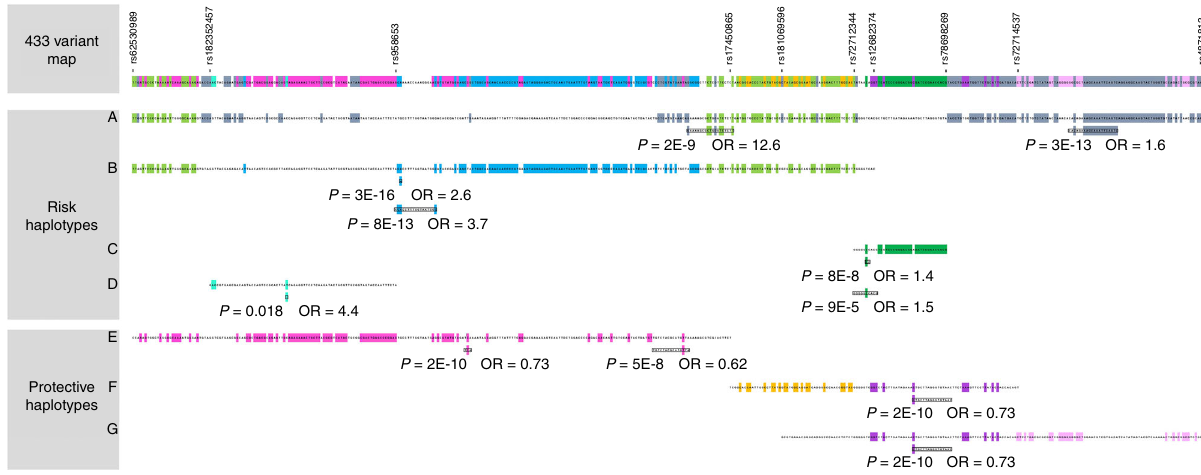
Fig. 3 Seven HPC risk-altering haplotypes carry the minor alleles of the 8q24 prostate cancer risk variants. These haplotypes are comprehensively reconstructed from all associated variants, displayed ordinally rather than on a physical scale. Four haplotypes conveying risk are illustrated above three others conveying protection. Each haplotype is distinguished from other risk-altering haplotypes by minor alleles of variants that are colorized (e.g., variants marking haplotype E are in magenta shade). Most variants had a minor allele residing upon only one of the risk-altering haplotypes. Variants in light green were the exception, with minor alleles that were shared by haplotypes A and B (potentially contributing to risk of both). The few remaining variants with minor alleles that were not unique to one among these haplotypes are left uncolorized. The direction of effect of a given minor allele was consistent with the direction of effect of the corresponding haplotype. Windows of peak signi fi cance and of peak effect size for each haplotype are denoted by inset boxes with corresponding P value and OR. Tests of association between hapotype and disease used multiplicative logistic regression models (additive genetic models), with two-sided signi fi cance assessed using Wald tests. For haplotypes D, F, and G, the window with the smallest P value also is that with the greatest effect size. Only near-Mendelian haplotype A extends across the full length of the map. Haplotypes are presented with additional detail in Supplementary Fig. 2. Source data are provided in Source Data fi le Tab 2. Variants at the ends of haplotypes A-G are denoted on the top